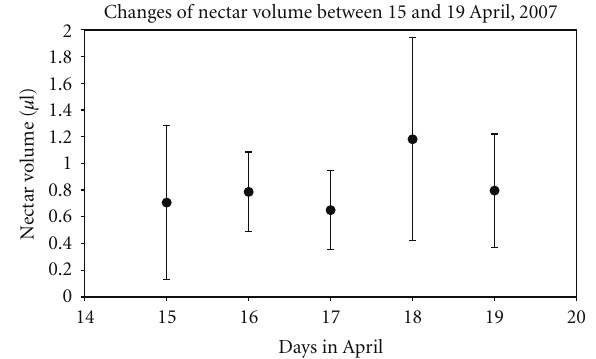
Figure 2: Nectar concentration (mean and standard deviation) in covered ramson flowers at site 3, on five consecutive days of full bloom in April